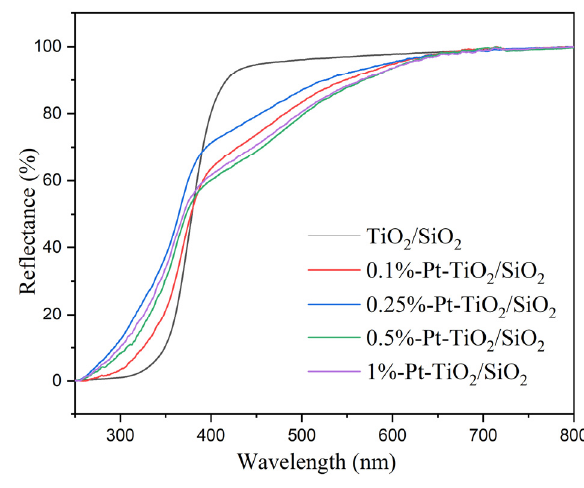
Figure 3. Diffuse reflectance spectra of the different synthesized materials.